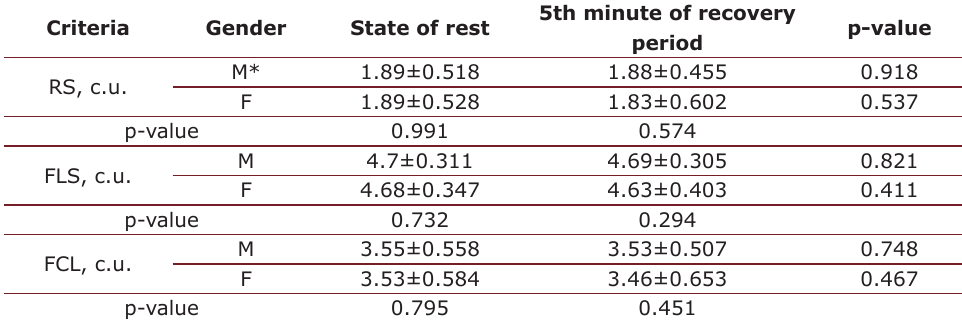
Table 1. Changes in indicators of the general functional state of the brain in female (n=58) and male students (n=82) with a high level of physical activity under the influence of bicycle physical load in a closed loop